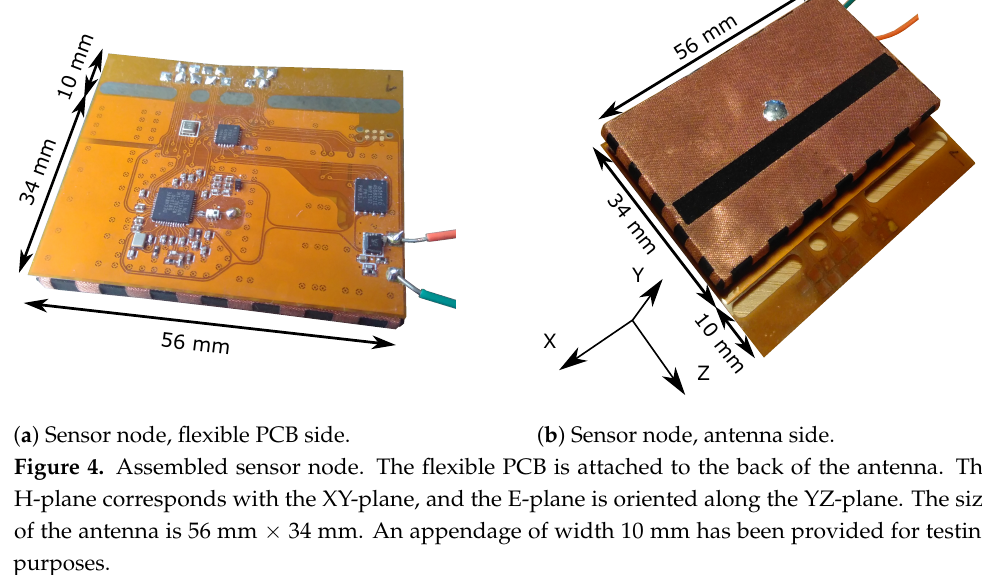
Figure 4. Assembled sensor node. The flexible PCB is attached to the back of the antenna. The H-plane corresponds with the XY-plane, and the E-plane is oriented along the YZ-plane. The size of the antenna is 56 mm × 34 mm. An appendage of width 10 mm has been provided for testing